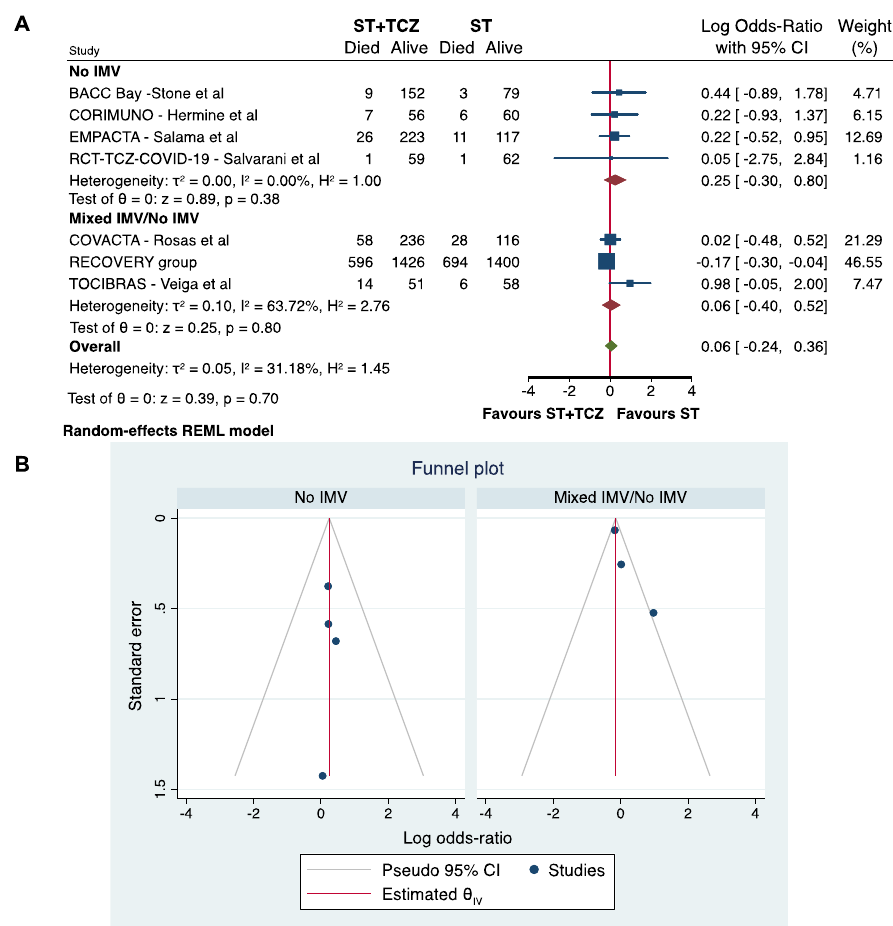
Figure 4. ( A ) Forest plot and ( B ) funnel plot of the subgroup analysis on the observational studies stratified by IMV use.